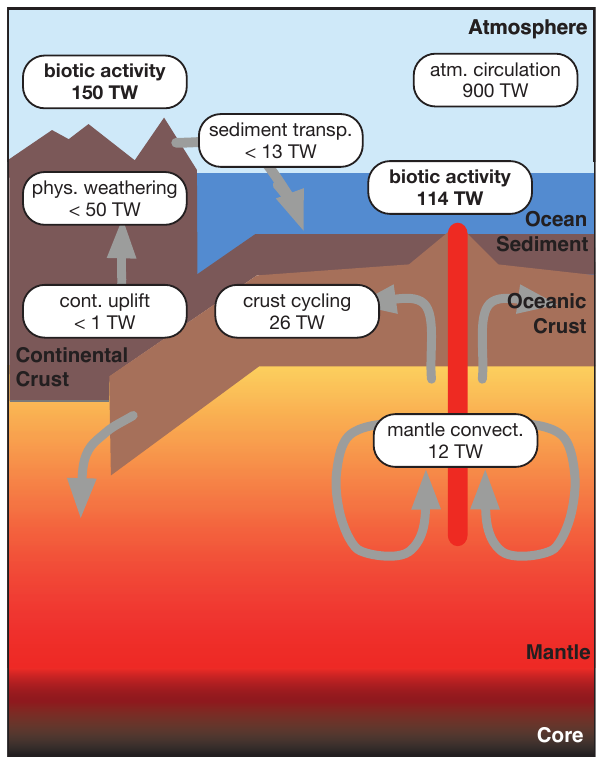
Fig. 15. Estimation of rates of work for components of the Earth system. Starting from estimates of net photosynthetic rates, biotic activity contributes a total of 264TW with 150TW and 114TW being produced by life on land in the oceans respectively. These and the other estimates of power should be understood in terms of the absolute maximum